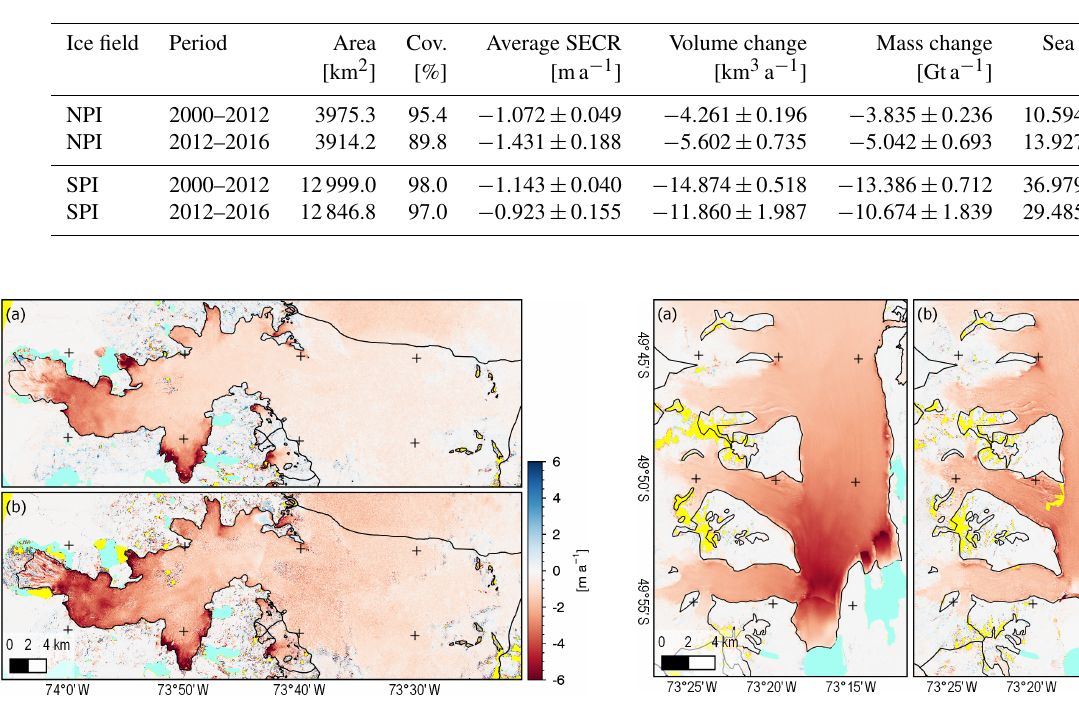
Figure 4. SECR of Upsala: (a) 2000–2012, (b) 2012–2016.